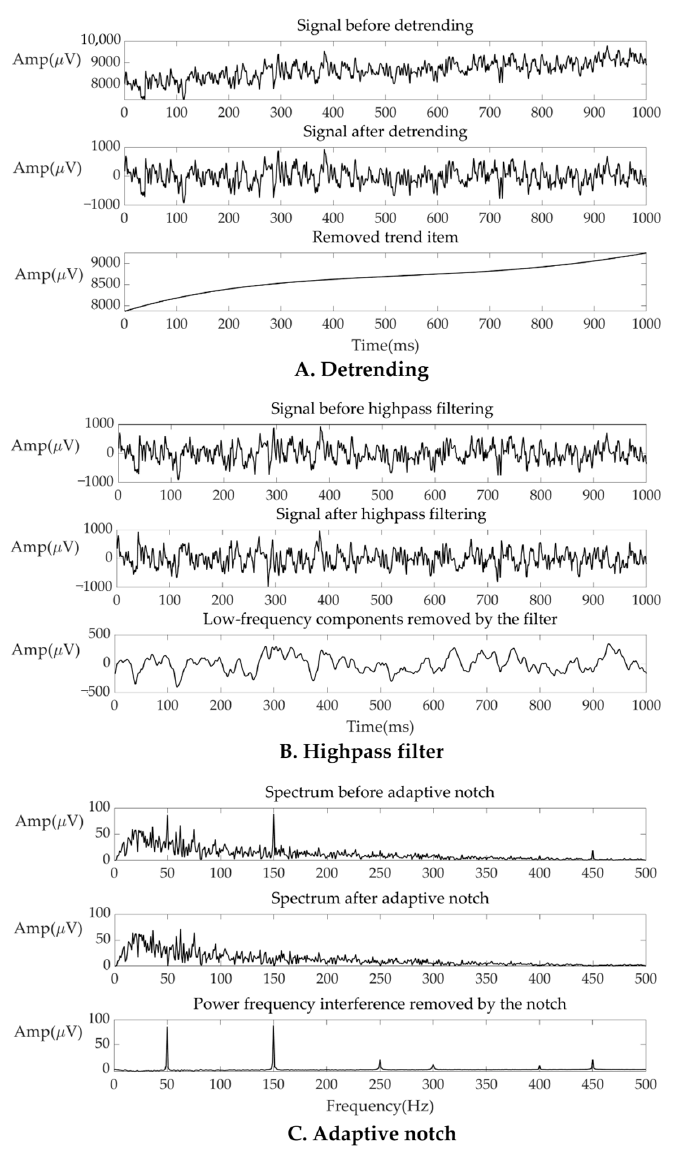
Figure 4. An example of the preprocessing result. ( A ) The signals before/after detrending and removed trend item ( B ) The signals before/after high-pass filter and the low-frequency components removed by the filter. ( C ) The spectrum of signal before/after adaptive notch and the spectrum of the power frequency interference removed by the